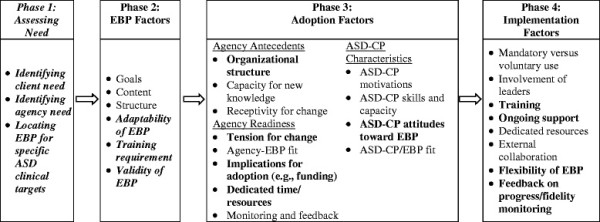
Preliminary conceptual model of the Autism Model of Implementation (Adapted from Aaronset al., 2011[13]; Damschroederet al., 2009[14]; and Greenhalghet al., 2004[15]). Note. Discussions with ACC Partners yielded: factors to be emphasized (bolded) and added (bolded and italicized).